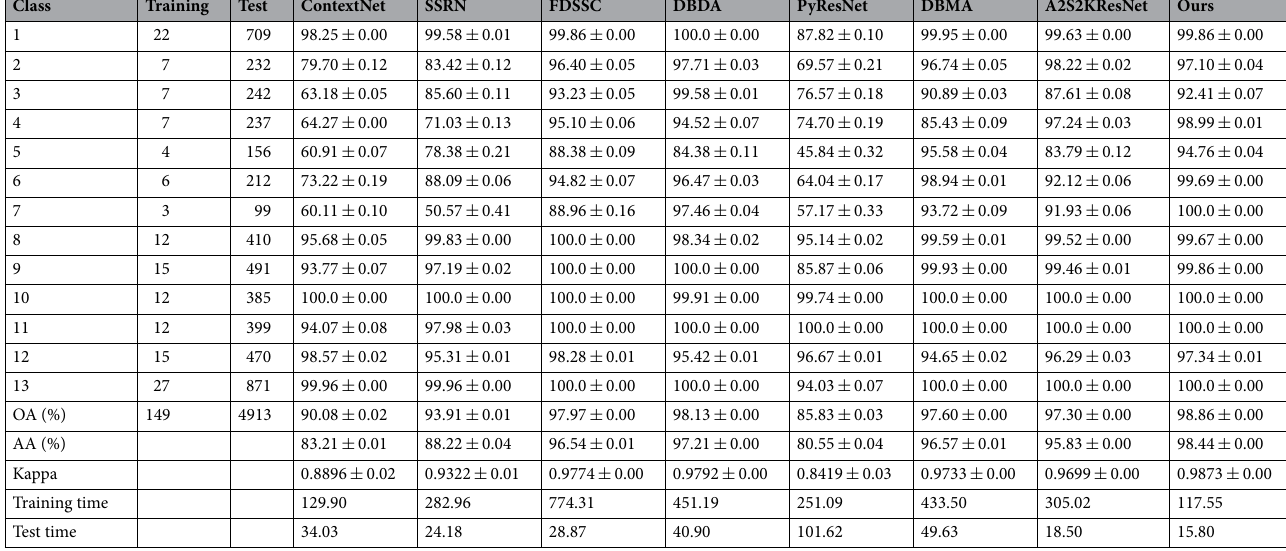
Table 3. The objective indicators on KSC dataset (using 3% training, 3% verification, 94% testing).